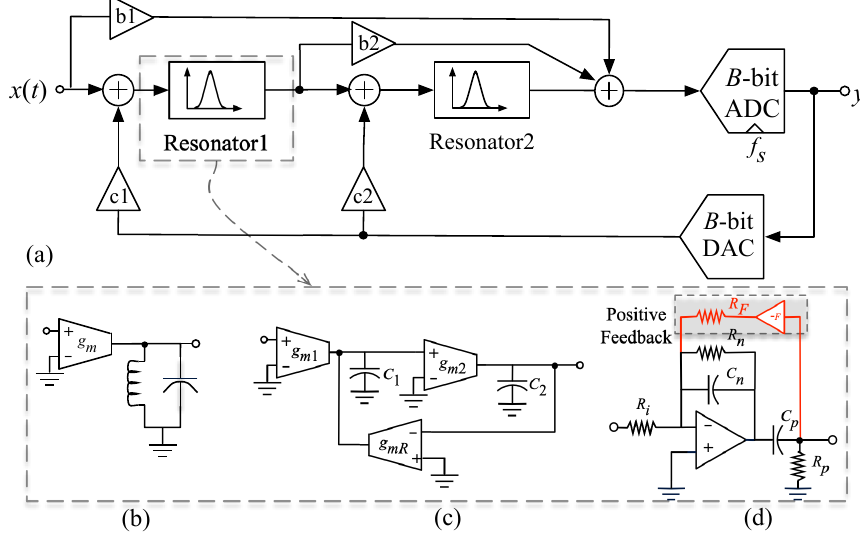
Figure 9. ( a ) Conceptual diagram of BP CT- Σ∆ Ms based on ( b ) LC-tank resonators, ( c ) active Gm-C integrators, and ( d ) single op amp resonators with Q-factor boosting